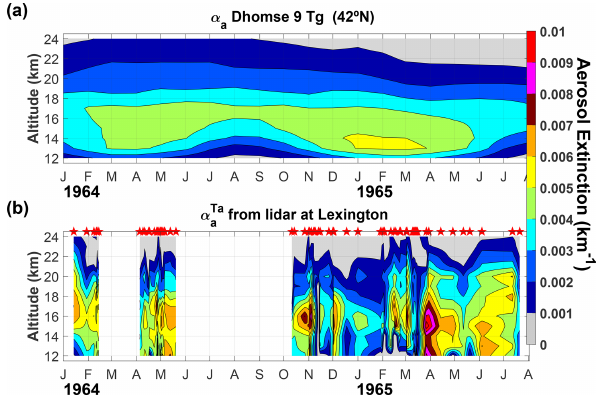
Figure 12. Contour plots of α a (532 ,z ) ∗ from Dhomse et al. (2020) at 42 ◦ N and measured aerosol extinction corrected for two-way transmittance α T a a (532 ,z ) from lidar for